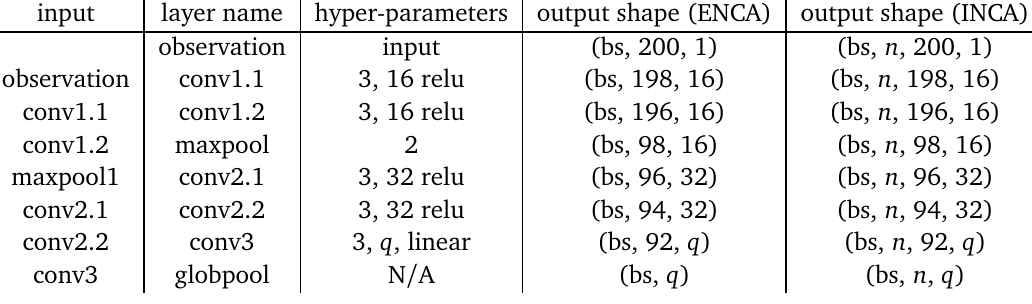
Table 1: Encoder architectures of the ENCA and INCA models. Global average pooling layer is denoted as globpool. Convolutional layer (conv) hyper-parameters correspond to kernel size, number of filters, and activation, respectively. Output shapes are listed for observation length of 200 steps and minibatch size is denoted as